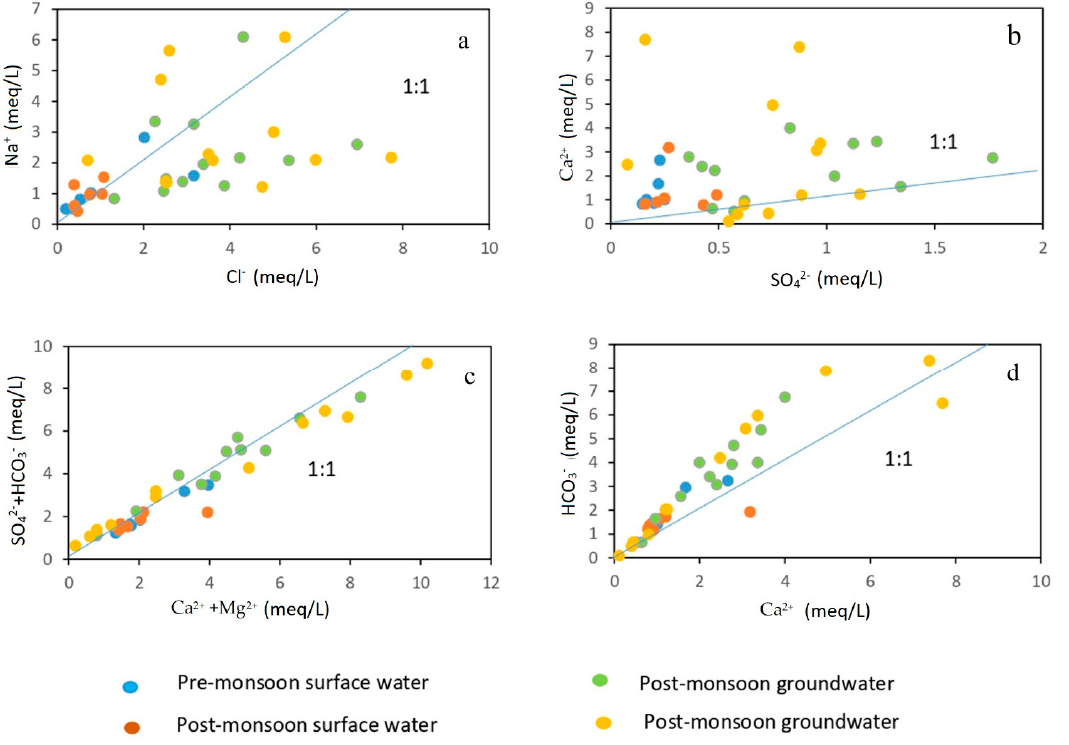
Figure 6. Scatter plots showing the correlation of major cations/anions to discriminate the geochem- ical processes. ( a ) Na + vs. Cl − , ( b ) Ca 2+ vs. SO 42 − , ( c ) (SO 42 − + HCO 3 − ) vs. (Ca 2+ + Mg 2+ ), ( d ) Ca 2+ vs. + vs. Cl − , ( b ) Ca 2+ vs. SO HCO 3 − . cal processes. ( a ) Na vs. HCO 3 −